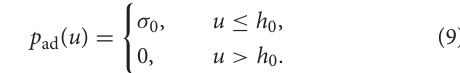
10 2 1/m, q 1 10 10 1/m, and H = =